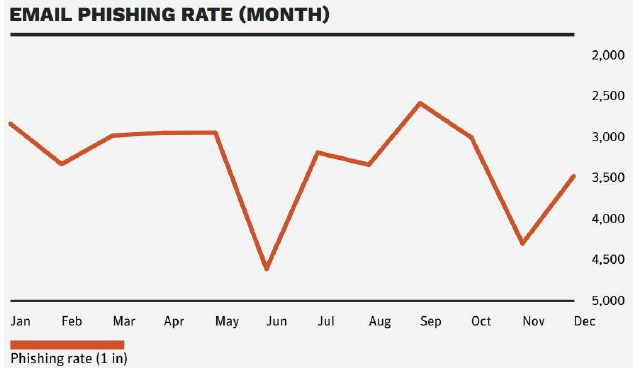
Fig. 2. Phishing rate during 2018 (Source: [14]).